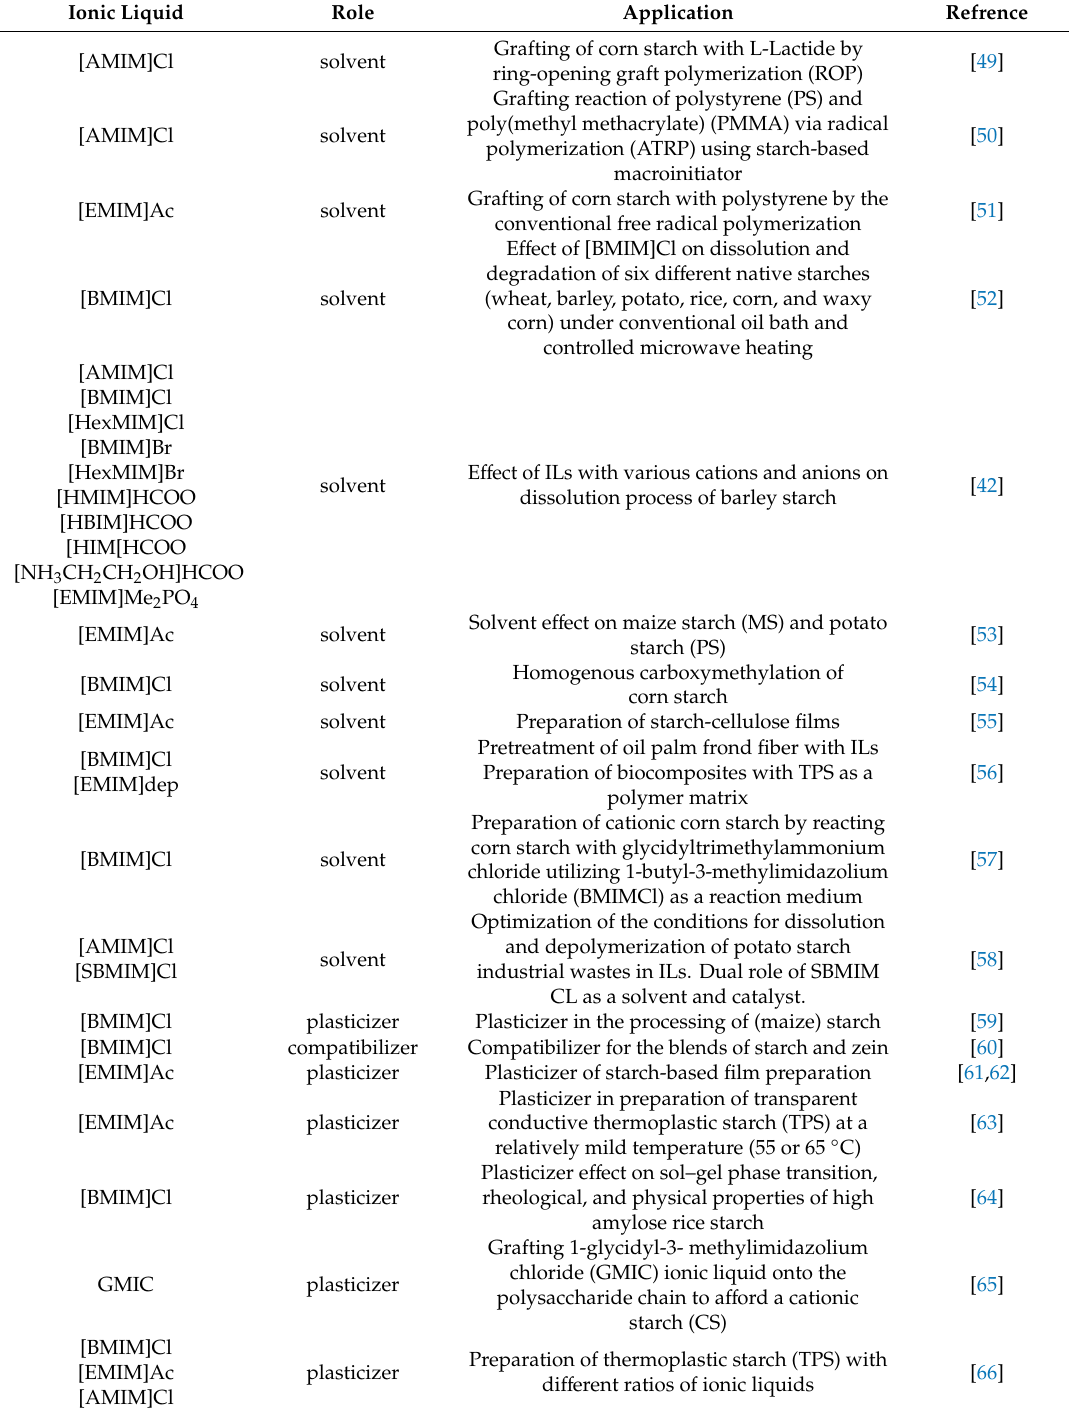
Table 2. ILs for dissolving and plasticizing